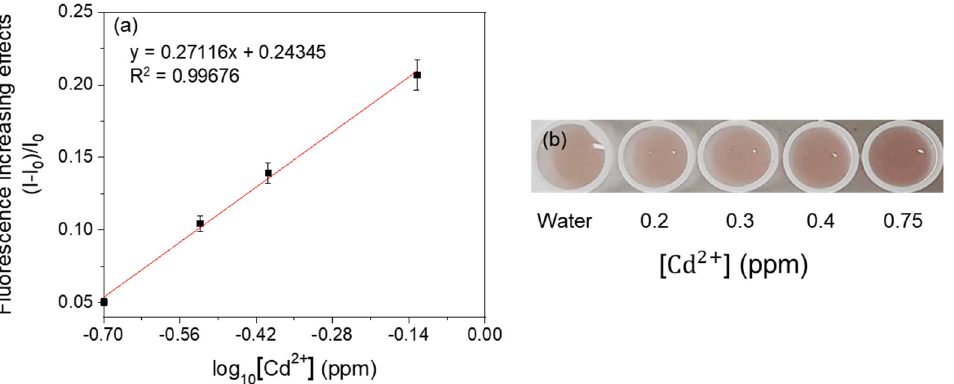
Figure 7. Concentration-dependent responses of fluorescent cadmium-sensing strain with cadmium. ( a ) The correlation between fluorescence increasing effects and cadmium concentration of the strain. ( b ) Visual detection of cadmium by the strain.